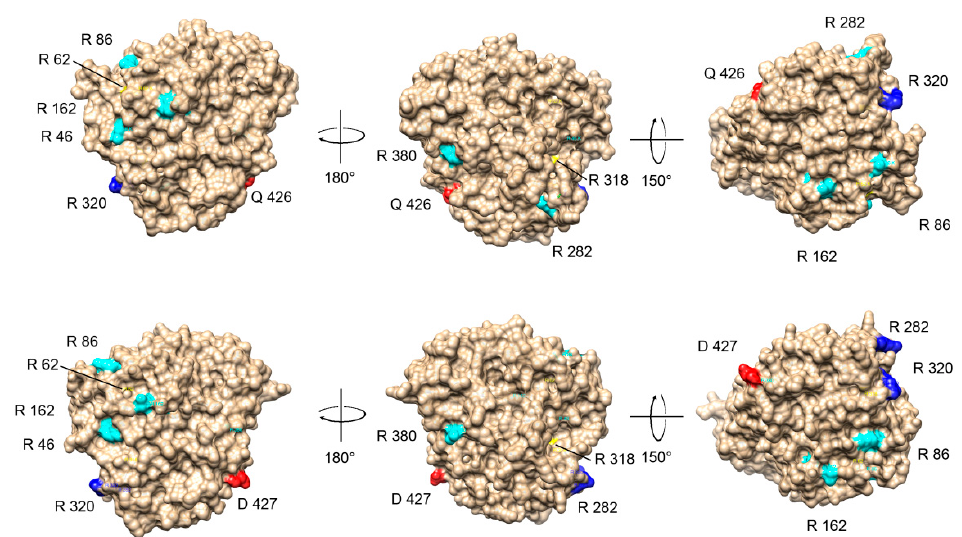
Figure 10. Comparison between arginine methylation sites in human and P. lividus β -tubulins. Top, ribbon/surface diagrams of the human neural β -tubulin structure Tubb3 (5JCO). Bottom, ribbon/surface diagrams of the neural β -tubulin structure generated by homology modelling. The 3D structures were created via the Phyre 2 software [87] and rendered by using Chimera package [88]. The arginine residues that can be methylated were coloured according to their accessibility on the surface: buried in yellow, intermediate accessibility in cyan, exposed in blue. The last amino acid shown in the structures (Q426 for the human protein and D427 for the P. lividus protein) are coloured in red as reference.